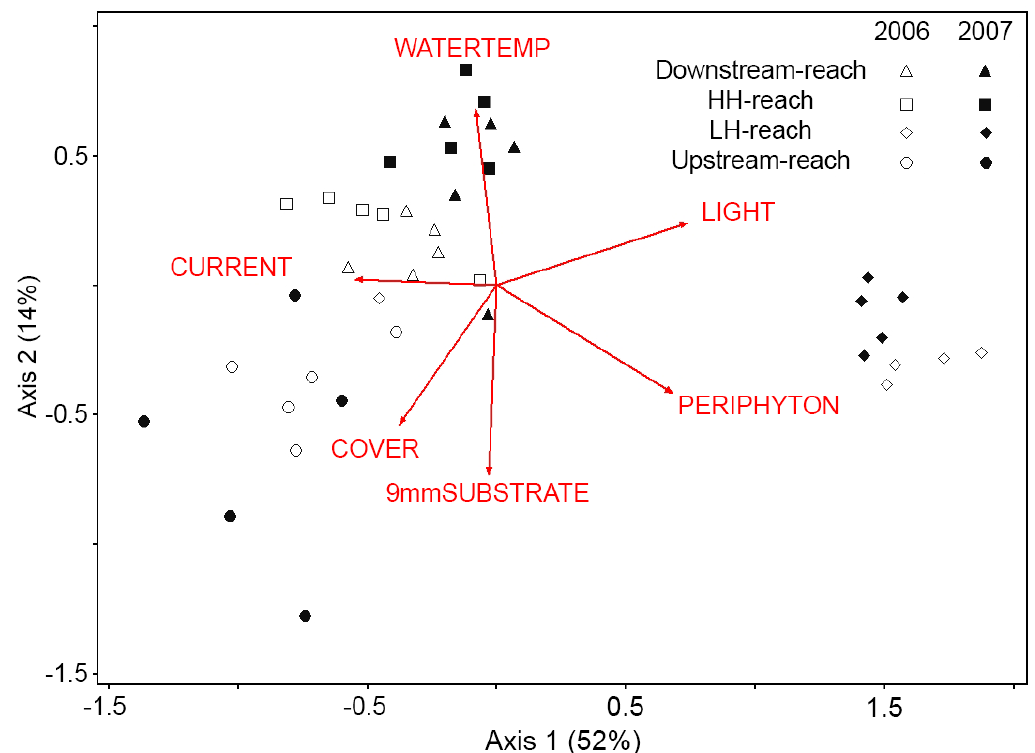
Figure 2. Nonmetric multidimensional scaling (NMS) biplot of five Surber samples per reach per year (n =40) in two-dimensional genera space. Samples plotted closer together have more similar macroinvertebrate communities. Percent variance represented by each axis is given in parentheses. Current velocity (CURRENT) is most strongly correlated with Axis 1 (r 2 = 0.32). Water temperature (WATERTEMP) is positively related (r 2 = 0.41) and small substrate size (9 mmSUBSTRATE) is negatively related (r 2 = 0.41) to Axis 2. Riparian canopy cover (COVER), periphyton biomass (PERIPHYTON), and solar availability (LIGHT) are related to both axes (r 2 > 0.23 for both